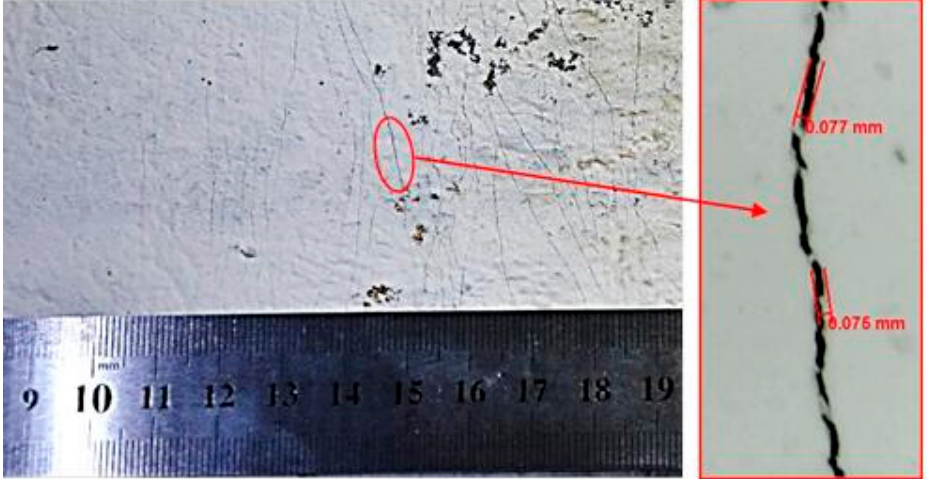
Figure 4. Maximum crack width on ECC layer during loading test.